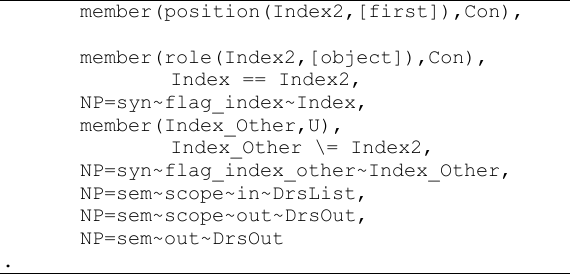
Figure 19. Implement Algorithm 6 based on framework